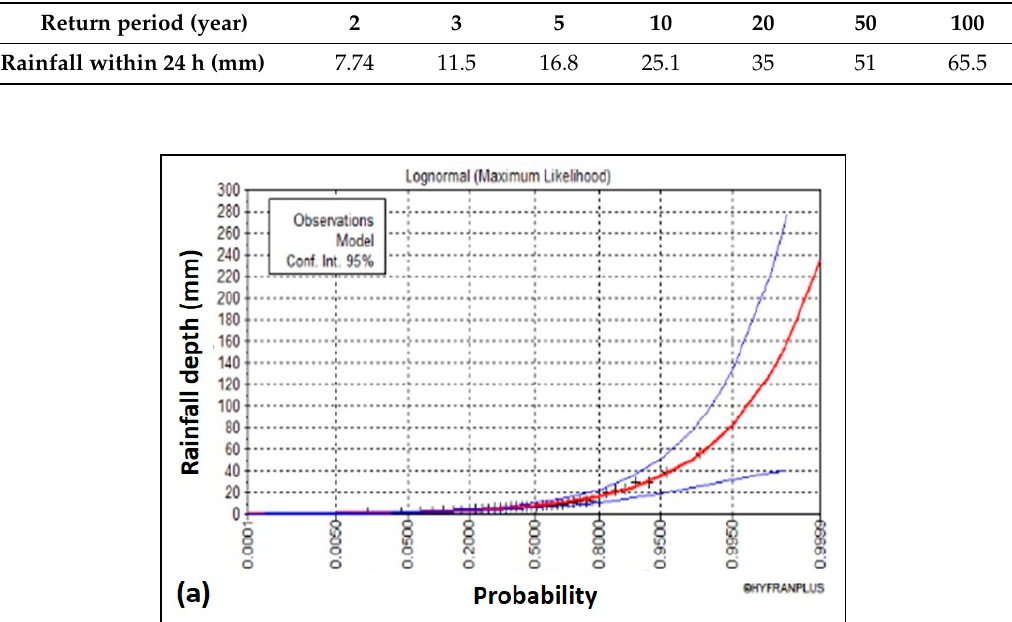
Table 2. Rainfall depths of different return periods at Tabuk station (TB001).